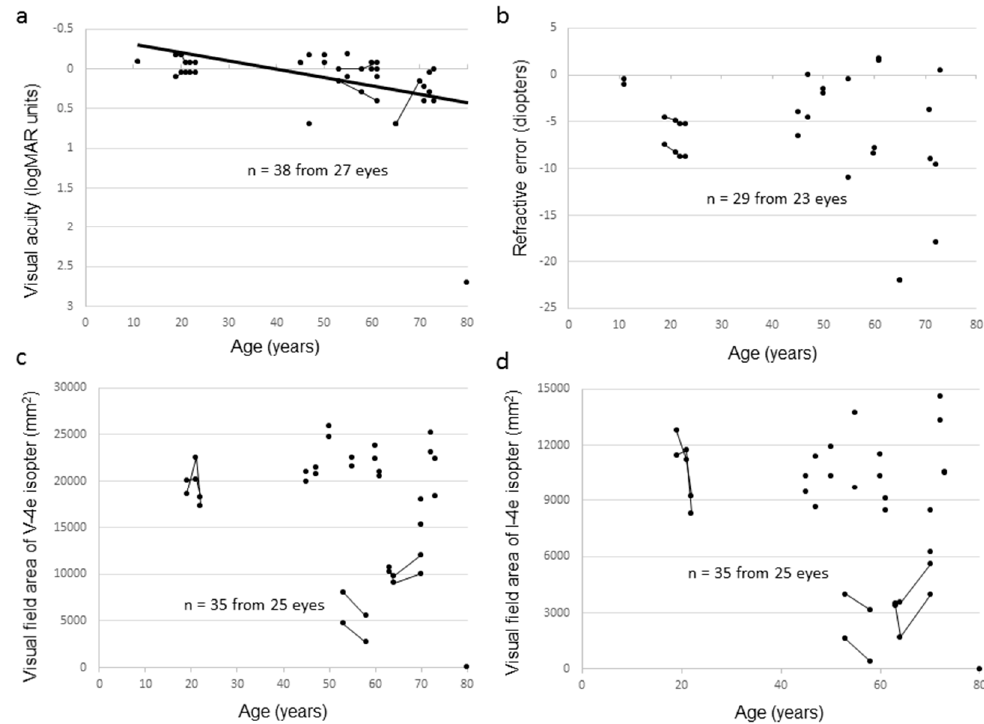
Figure 3. Correlation between visual function and age among carrier female subjects in this study. The graphs show visual acuity values expressed in logMAR units ( a ), refractive error ( b ), visual field extent with the V-4e isopter ( c ), and visual field extent with the I-4e isopter ( d ) versus age. The data from the same subject are indicated using bars connecting the points.